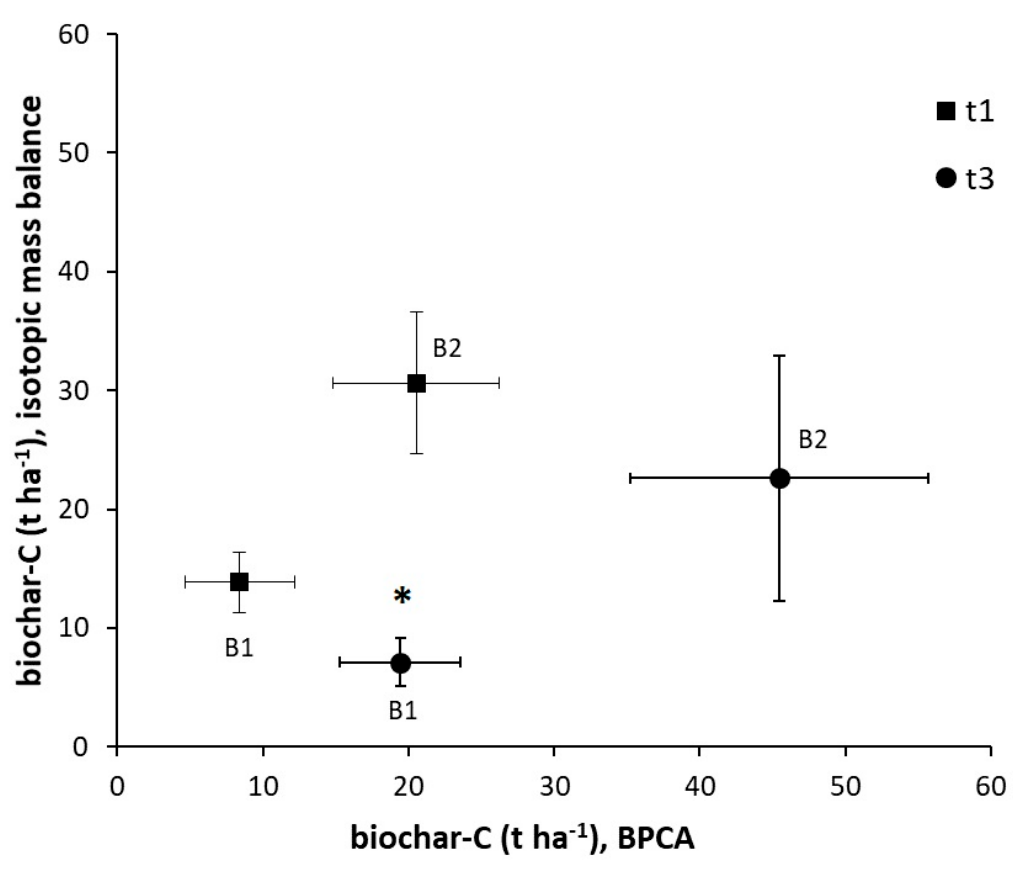
Figure 4. Comparison of soil biochar-C estimates (t ha − 1 ) obtained using the isotopic mass balance method (Y-axis) and the BPCA analysis (X-axis) in treatments B1 and B2, three weeks after biochar application to soil (t1) and two years later (t3). The error bars represent the standard error of the mean and the asterisk indicates a significant difference between the estimates obtained with the two analytical